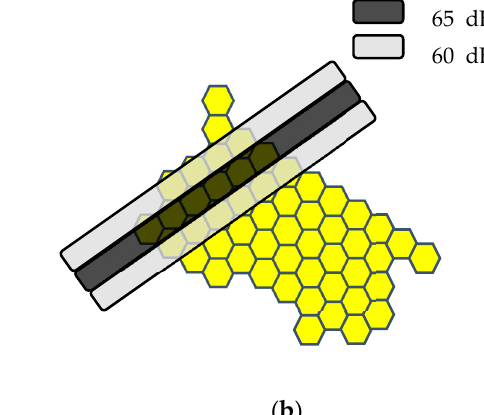
Figure 10. ( a ) Virtual noise width of eVTOL passing through the actual city; ( b ) virtual noise width of eVTOL passing through a virtual city modeled in an ideal space.